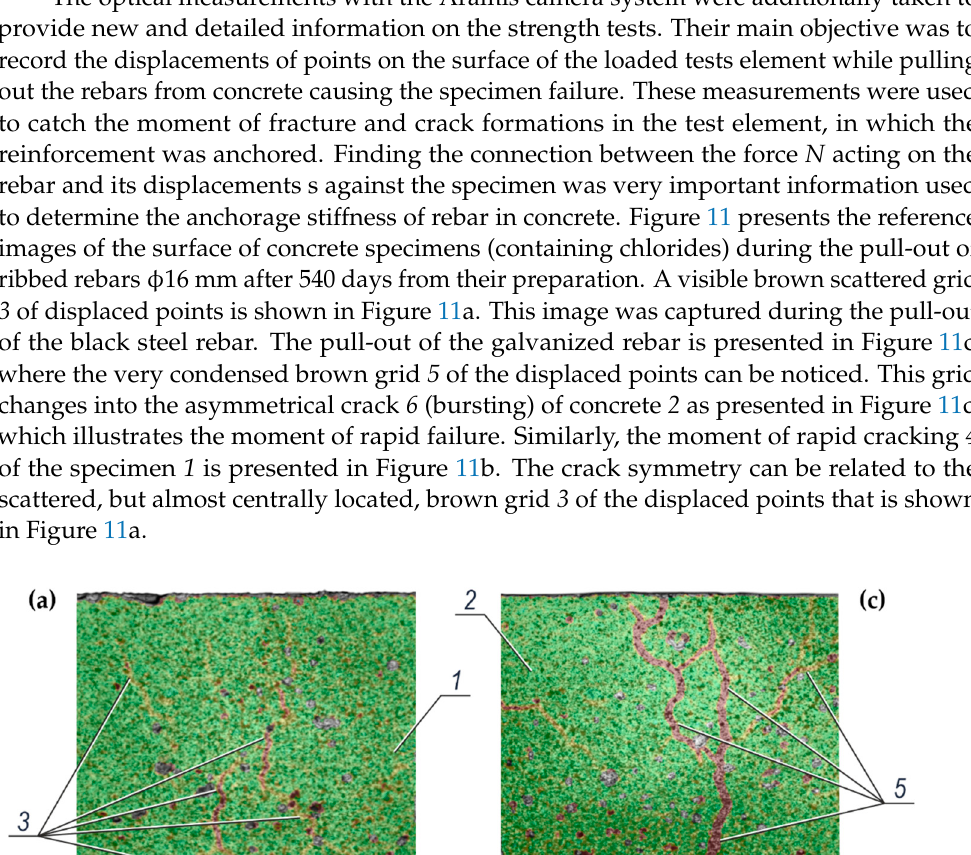
Figure 10. The results from electrochemical tests on reinforcing steel in concrete on days 3, 10, and 25 from setting the specimens in concrete: ( a ) corrosion current density i corr determined with the LPR technique, ( b ) the test elements with galvanized and black reinforcing steel (smooth ϕ 8 mm and ribbed ϕ 8 and ϕ 16 mm) in concrete with and without chlorides.